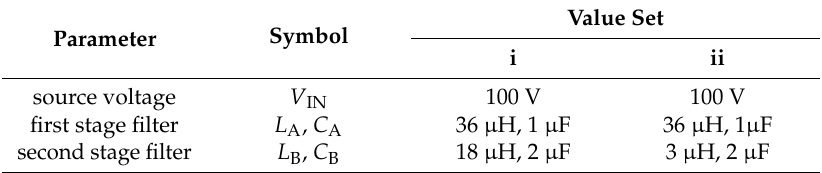
Figure 2. Open-loop frequency response of GaN class-D amplifier with fourth-order filter using ( a ) value set-i in Table 1 and ( b ) value set-ii in Table 1.